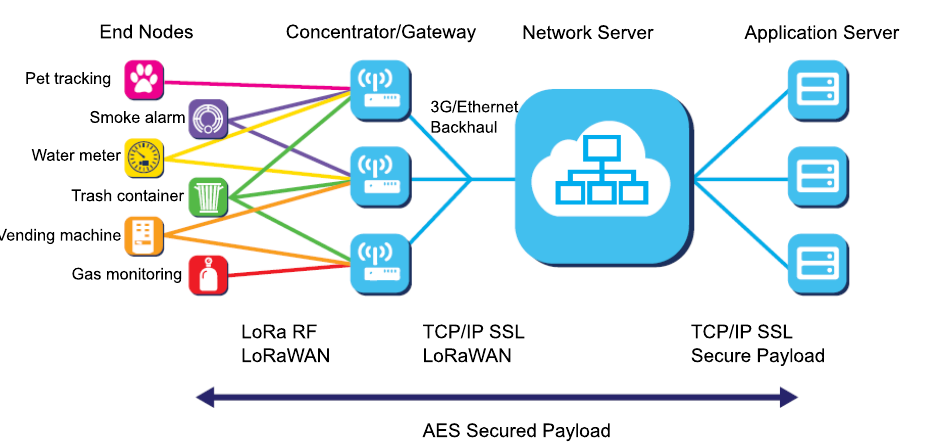
Figure 1. General overview of long-range (LoRa)/LoRa wireless area network (WAN)